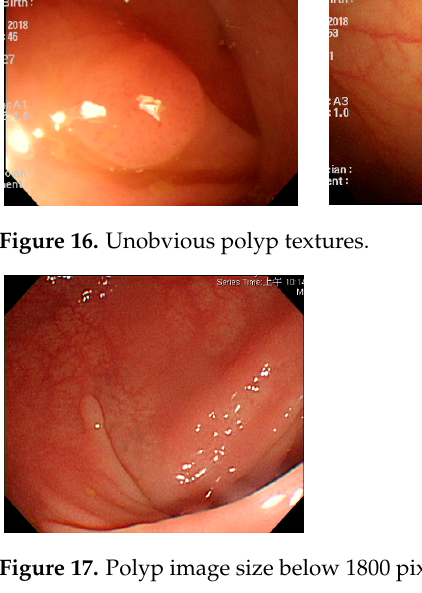
Figure 17. polyp image size below 1800 pixels.